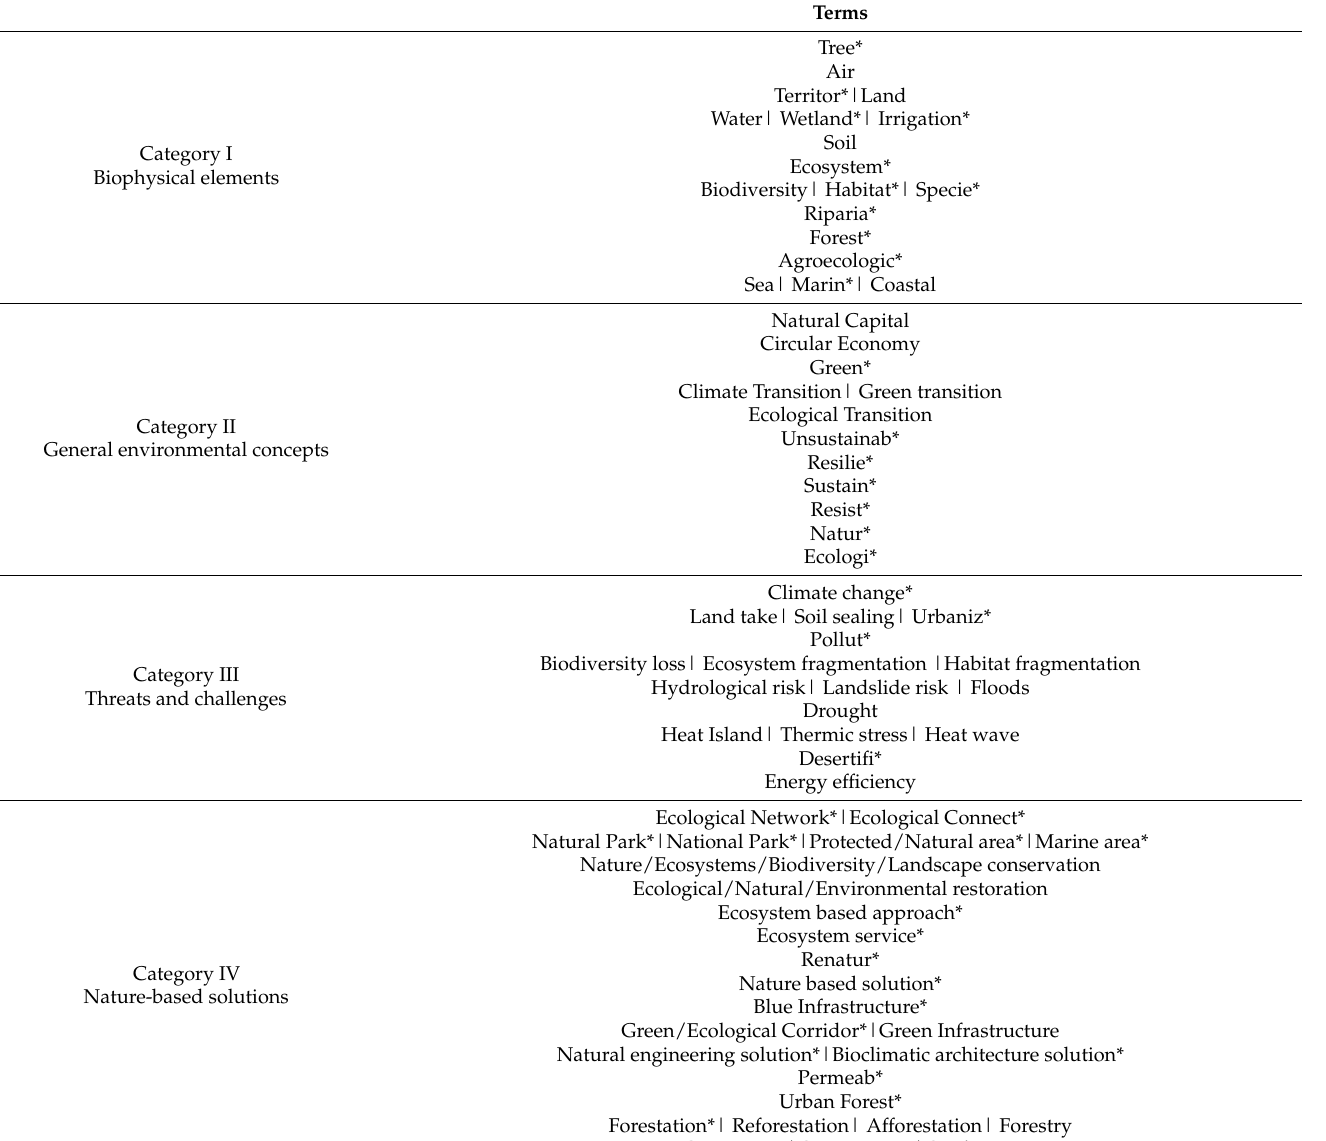
Table 1. Coded terms and associated words, aggregated into four categories, “biophysical elements”— category I, “general environmental concepts” related to environment and ecological transition (hereafter “general environmental concepts”)—category II, “threats and challenges” potentially addressed by NBS (hereafter “threats and challenges”)—category III, and “different ecosystem-based approaches” (hereafter “NBS”)—category IV. The use of the “*” at the end of the word accounted for both the plural and all the related